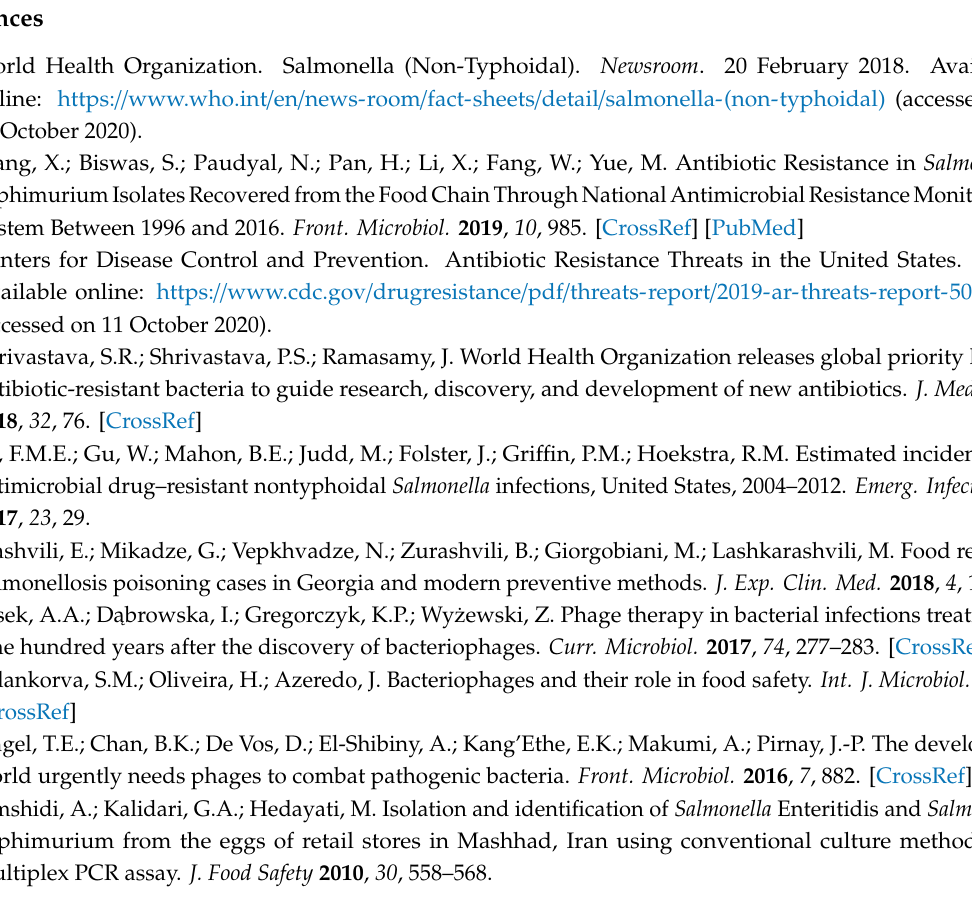
Table S1: Distribution of MDR isolates and their antimicrobial resistance profiles, Table S2: SNP variant analysis of GEC_vB_B3 and the closely related GEC_vB_B1 using iVar, Table S3: SNP variant analysis of GEC_vB_N8 and the closely related GEC_vB_N5 using